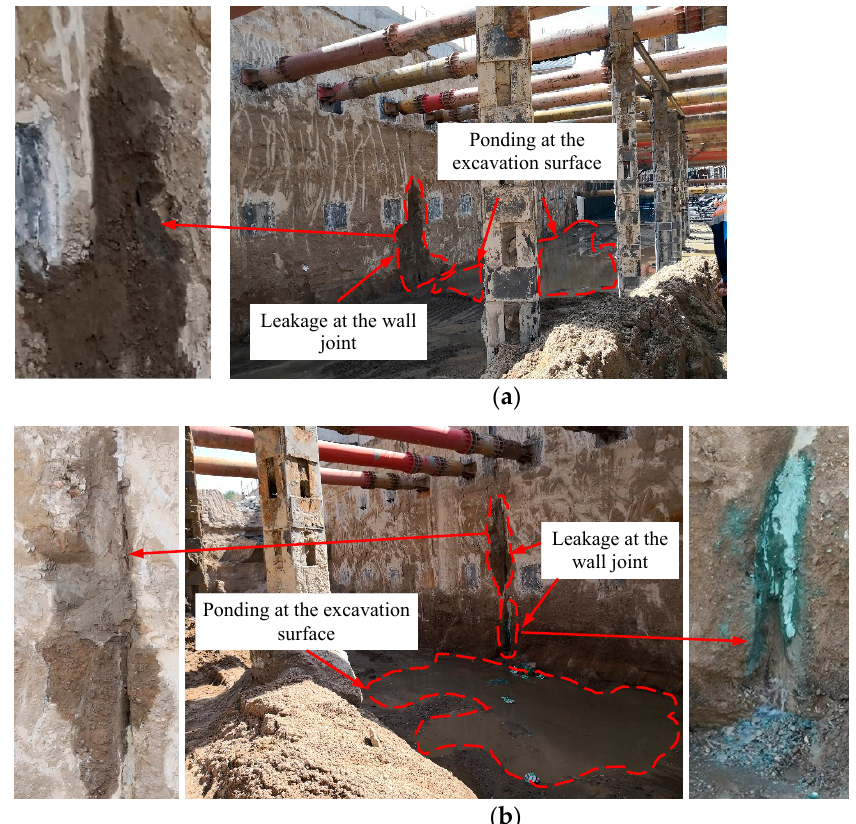
Figure 5. Photographs showing water leakage occurring in the wall joints at the site. The leaks were observed in: ( a ) the east side wall, and ( b ) the west side wall.